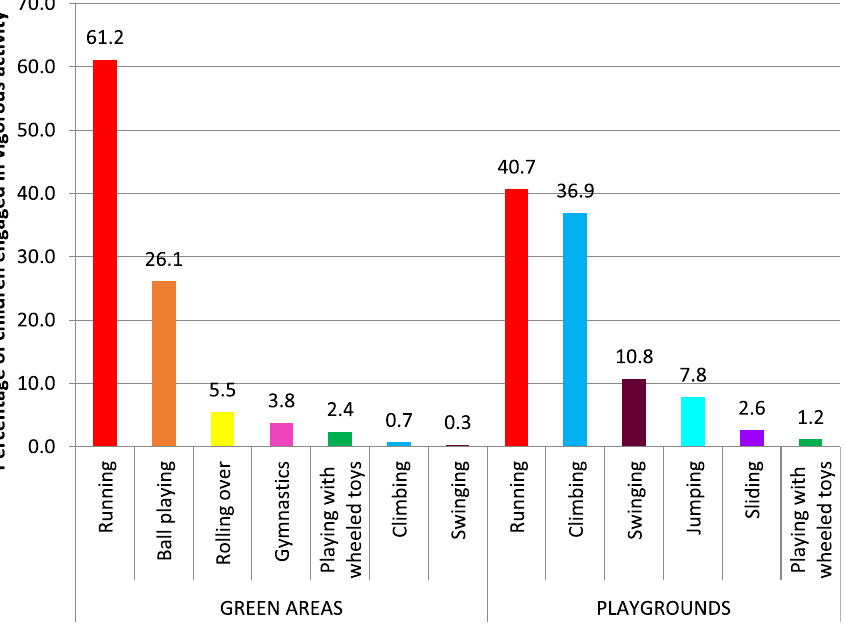
Fig. 3 Types of vigorous activities observed in green areas and playgrounds